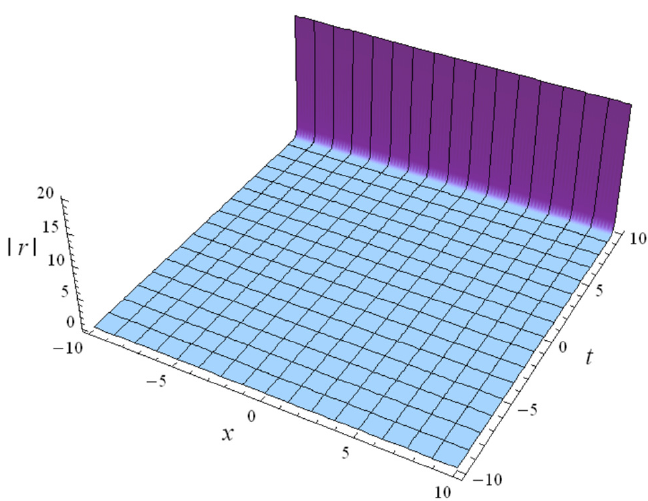
Figure 3. Space–time dynamical evolution of solution (116) with κ 1 ( 0 ) = 0.5, κ 1 ( 0 ) = 0.3, c 1 ( 0 ) = 1, c 1 ( 0 ) = − 2 × 10 − 15 , α ( t ) = t − 1, β ( t ) = t , γ ( t ) = t 2 + 1 and δ ( t ) = i